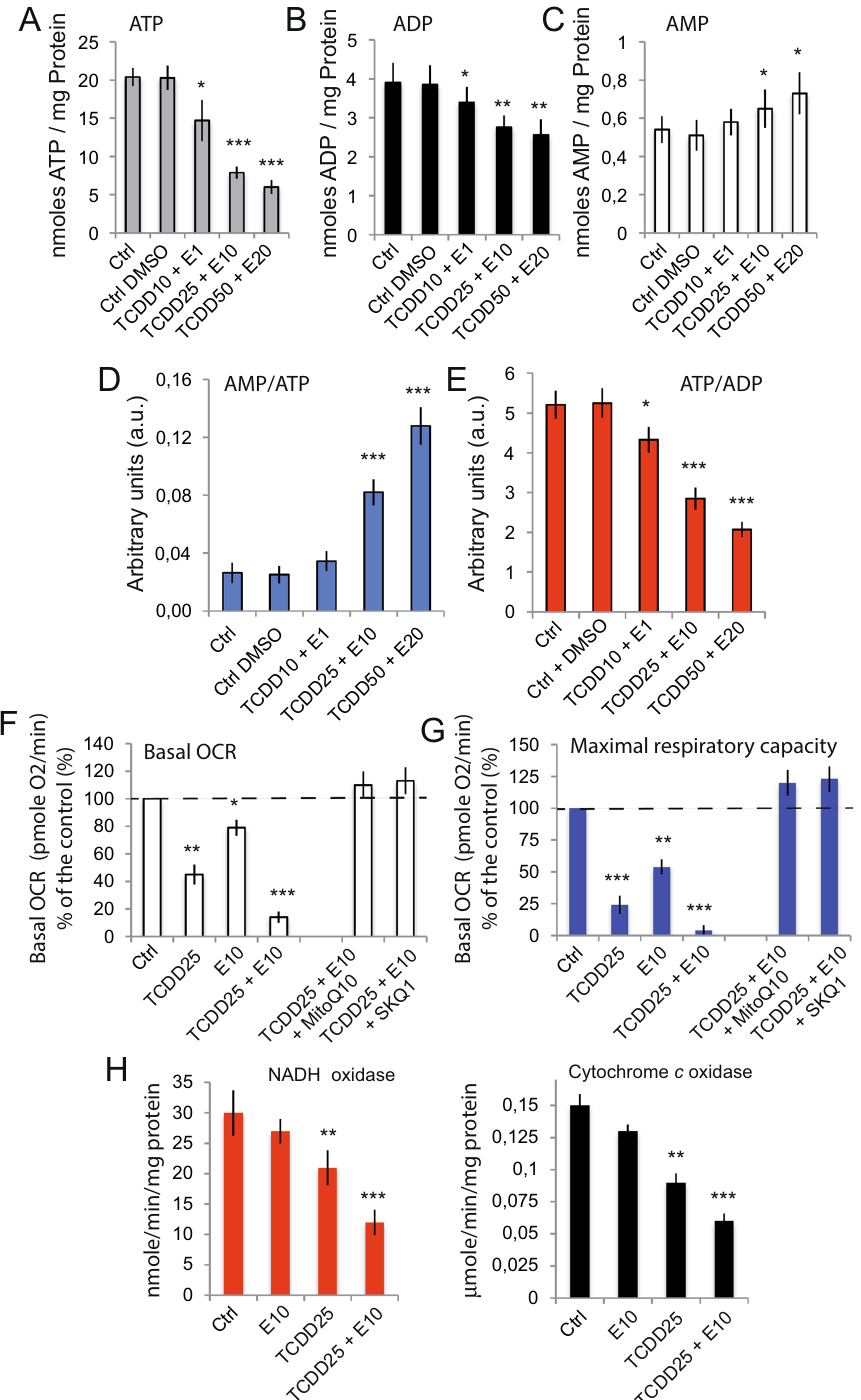
Figure 5. Analysis of diverses bioenergetic parameters concerning cells or mitochondrial isolated from cells which have been treated by diverses TCDD + α -E cocktails. ( A – E ) HPLC determination of the ATP, ADP and AMP levels in cells treated with different concentrations of TCDD + E (dosage expressed as nmoles/mg protein). AMP/ATP and ATP/ADP ratios are respectively presented in D and E (arbitrary units). From A to E, the statistics are based on 6 differents experiments (n = 6). ( F and G ) Seahorse analysis of the cellular respiration for Caco-2 cells treated with TCDD or α -E, or TCDD + α -E cocktails. ( F ) basal oxidative respiratory chain (ORC) and in ( G ) Maximal respiratory capacity after 10 μ M mClCCCP addition (n = 4). On these two panels F and G, the mitochondrially targeted antioxidants MitoQ10 100 μ M and SKQ1 5 nM have been used to minimize the superoxide anion production. TCDD alone at 25 nM, α -E at 10 nM and the cocktail TCDD 25 nM + α -E 10 nM. MitoQ10 is used at 500 mM and SKQ1 at 25 μ M. ( H and I ) NADH oxidation ( H ) and Cytochrome c oxidase activity ( I ) of isolated mitochondia treated with α -E 10, TCDD 25 or a mixture of TCDD + α -E (25 + 10) (n =